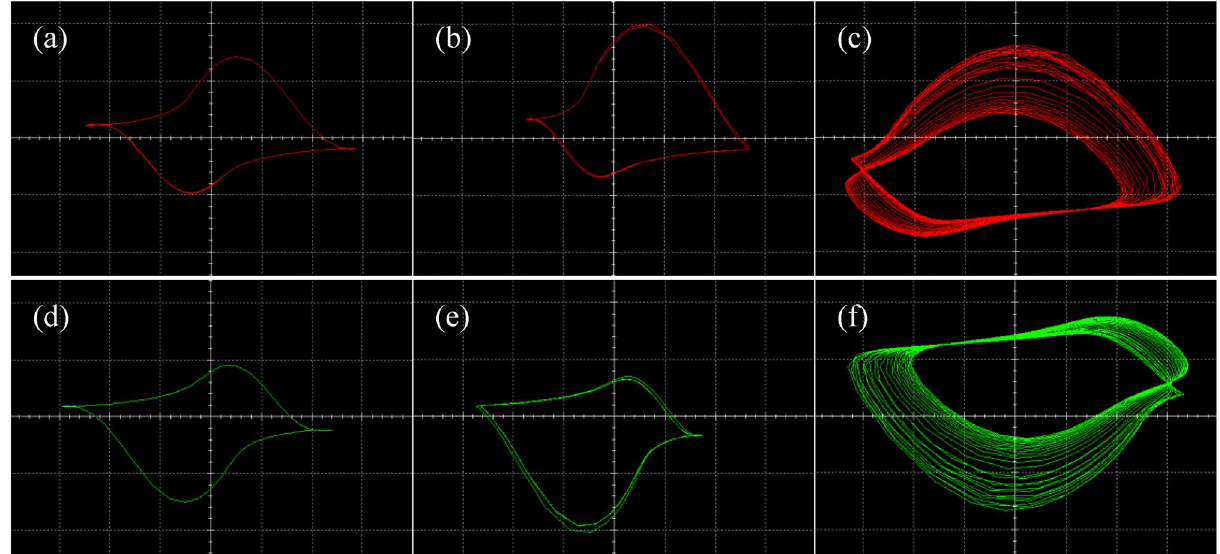
Figure 11. The symmetric coexisting attractors obtained from the designed circuit with the channels of v c 1 and